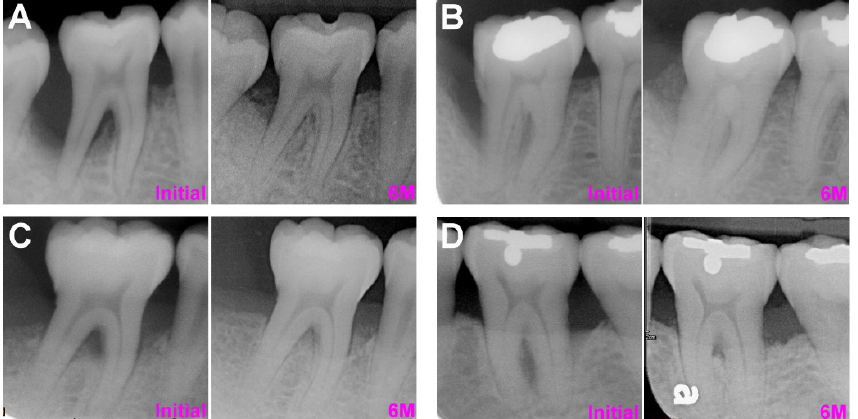
Abbreviations: LFI: the linear furcation regeneration improvement; RLI: the ratio of LFI; ALF: the adjusted LFI; ARL: the adjusted ratio of LFI; IRI: the improvement of radiographic intensity; BRG: the bone replacement graft; FDBA: freeze-dried bone matrix; DBBM: deproteinized bovine bone matrix; CM: collagen membrane; EMD: enamel matrix derivatives.